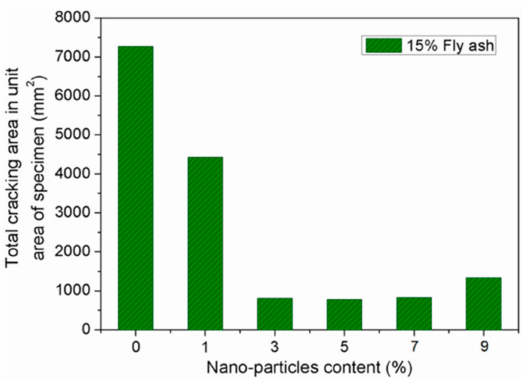
Figure 5. Influence of nano-silica dosage on the total cracking area per area unit of concrete specimens. Reprinted with permission from [84]. Copyright © 2019, MDPI AG.